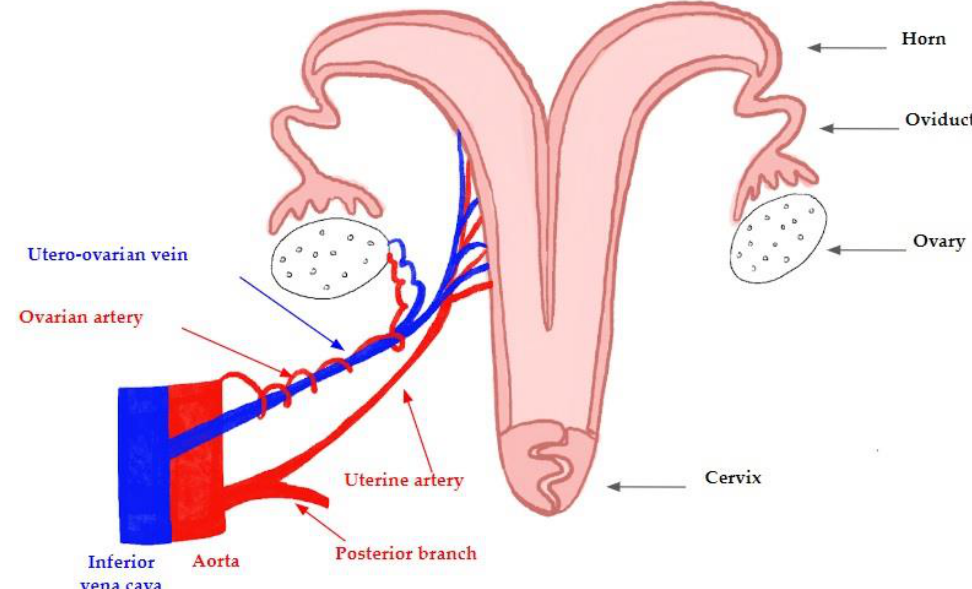
Figure 3. The anatomy and vascularization of the ovine uterus: the uterine artery and the utero-ovarian vein originate from the internal iliac vessels (trifurcation from the aorta and the vena cava, respectively).